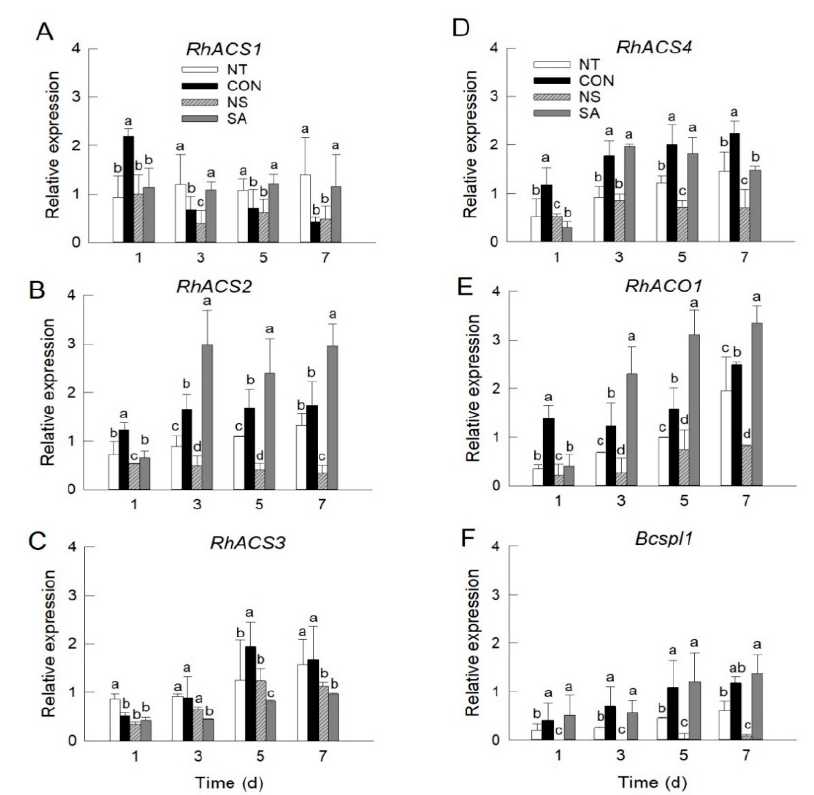
Figure 2. Effect of B. cinerea infection on transcript levels of RhACS1 ( A ), RhACS2 ( B ), RhACS3 ( C ), RhACS4 ( D ), RhACO1 ( E ), and Bcspl1 ( F ) in petals of cut roses. mRNA levels of ethylene biosynthesis and Bcspl1 genes were detected on days 1, 3, 5, and 7 after the transport simulation. NT, non-treated flowers; CON, flowers were held in distilled water; NS and SA, cut flowers were treated with nano silver and salicylic acid. CON, NS, and SA flowers were sprayed with B. cinerea conidial suspension to induce gray mold development. All flowers were then stored at 10 ± 2 °C and 80–90% RH in dark conditions for 4 d for export simulation. Different letters above bars indicate statistically significant differences among treatments at p = 0.05 based on Duncan’s multiple range test. Vertical bars show standard errors of the means ( n = 3).